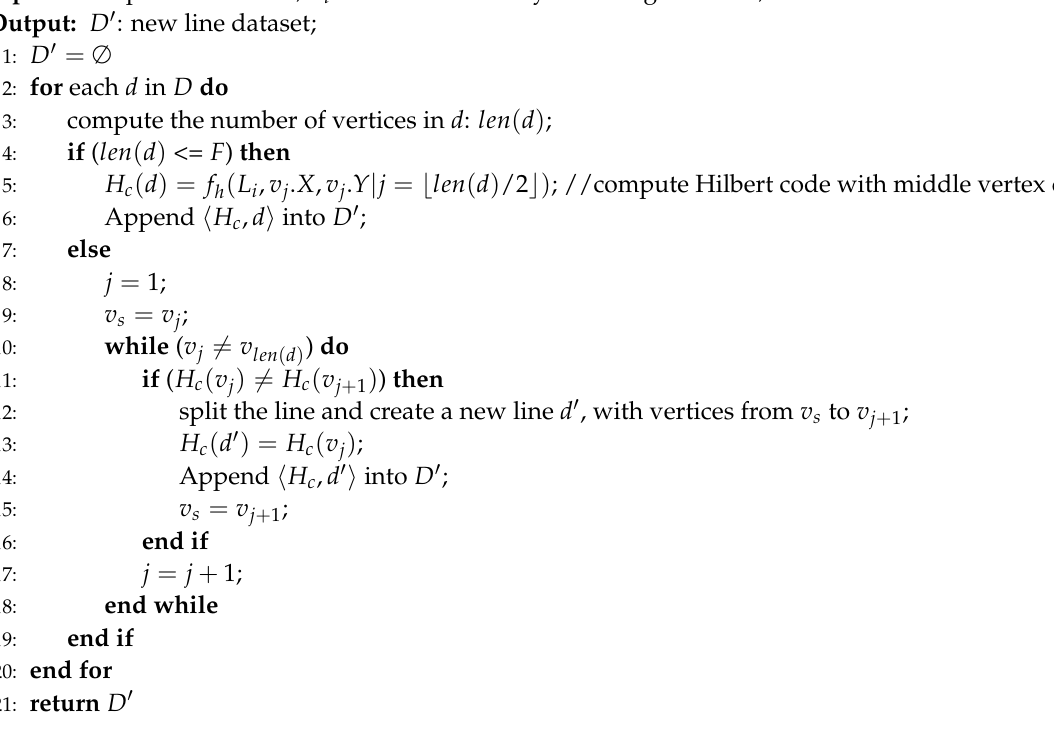
Algorithm 2 Boundary Object Assigning and Splitting Algorithm.